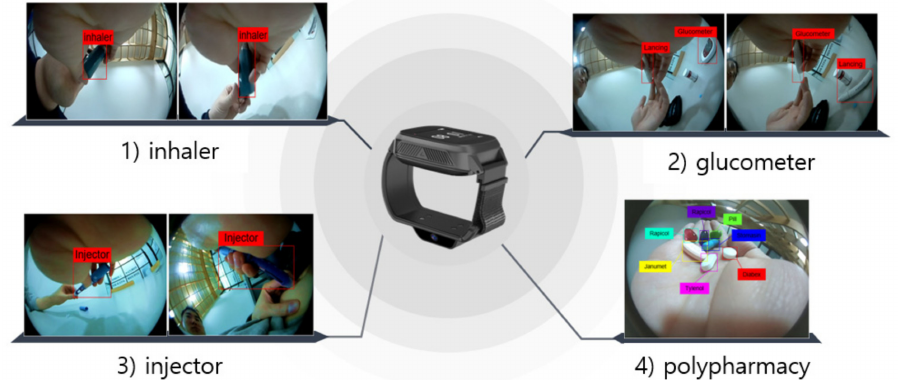
Figure 10. Expansion of smartwatch-based AI analysis